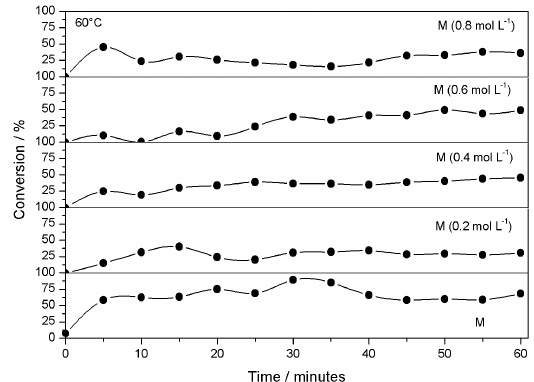
Figure 5. Conversion of oleic acid at 60 °C, using natural montmorillonite clay and treated montmorillonite clay with sulfuric acid at different concentrations (0.2 – 0.8 mol L –1